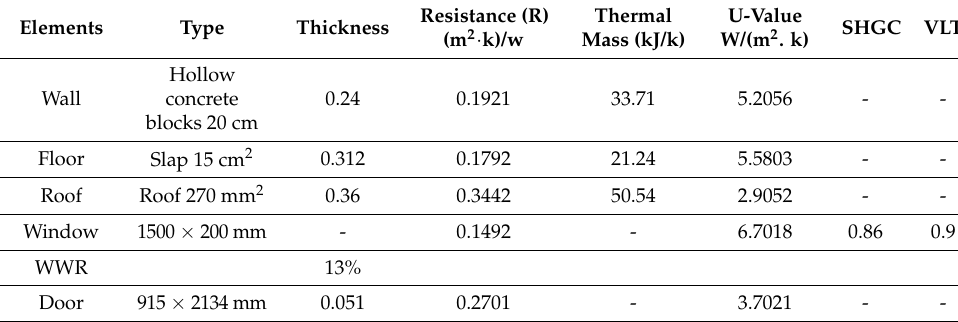
Table 4. Envelope components’ analytical properties (Case 1).